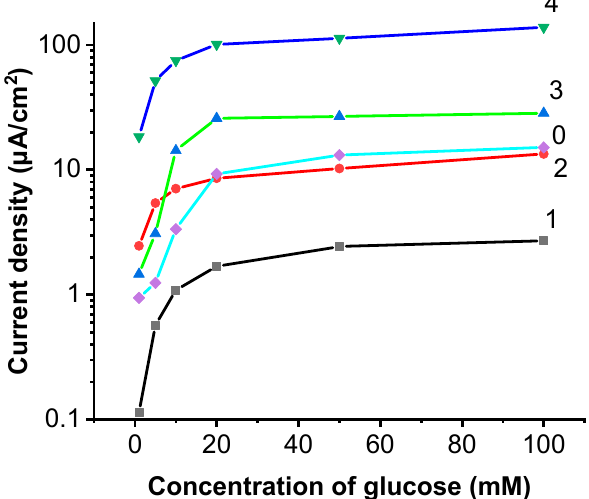
Figure 6. Current density dependency on glucose concentration. Δ J , log10( J i − J 0 ) from the concentration of glucose, where J i —current density is measured after the addition of glucose, and J 0 —current density is measured at the start of the experiment: 0—control of the study; 1—EBFC CC ; 2—EBFC CA ; 3—EBFC ChV ; and 4—EBFC Hep .